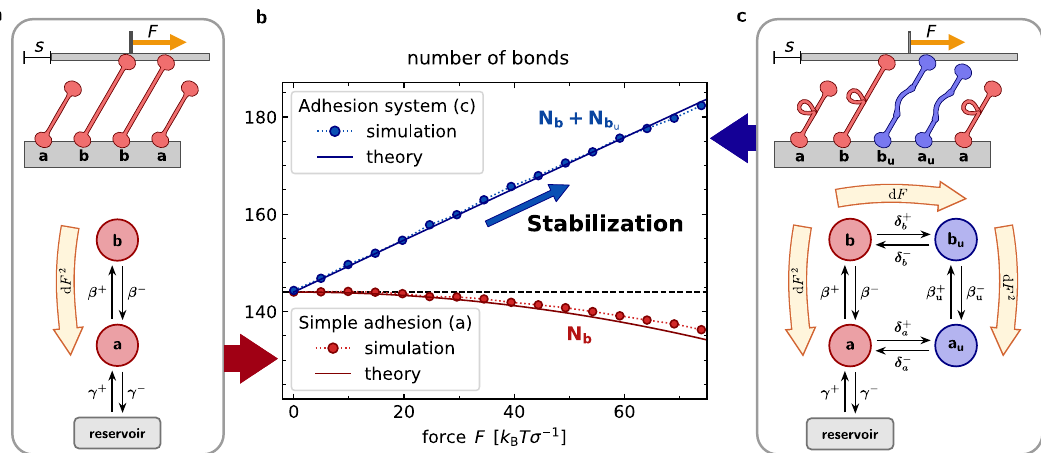
Fig. 1 Adhesion self-stabilization. a Illustration of the basic adhesion model which consists of unbound molecules a and bonds b that connect two parallel rigid planes. A tangential load stretches all molecules in state b as it shifts the upper boundary by s . Molecules can transition between states b and a with extension-dependent rupture and binding rates given by β − ( h ) and β + ( h ). Molecules can enter or leave the adhesion cluster with rate constants given by γ ± . The decrease of the ratio of bound to unbound molecules under a small force d F is a second order effect (orange arrow). b Mean number of bonds in steady state as a function of loading force. Markers show simulation results and lines correspond to approximate analytical results. In the basic model, an increased load on the adhesion reduces the number of bonds (red). In contrast, an increased load produces a growth of the number of bonds in the generalized model (blue). c Illustration of the generalized adhesion model incorporating molecule unfolding and refolding with rates δ ± a ; b ð h Þ as well as a molecule-exchange with the reservoir. Mechanical load drives the system out of equilibrium, shifting the state occupations, as indicated by orange arrows for changes up to second order. See also Supplementary Movies 1,